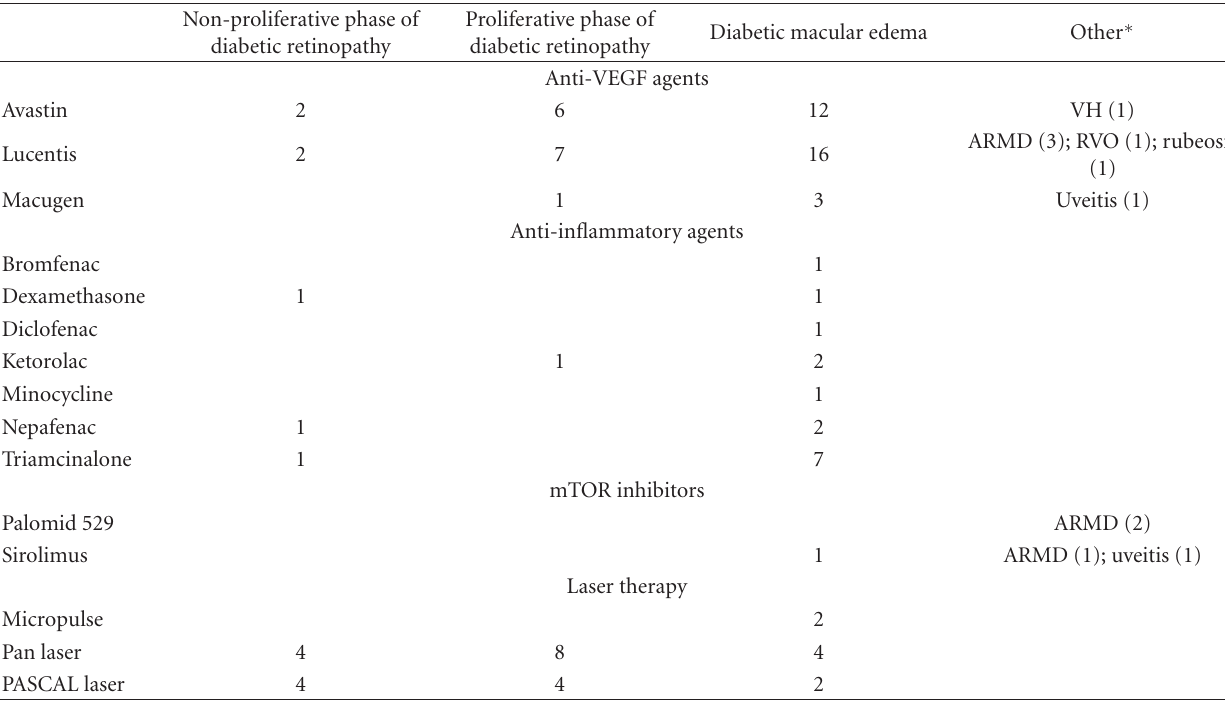
Table 1: Number of open NIH trials by